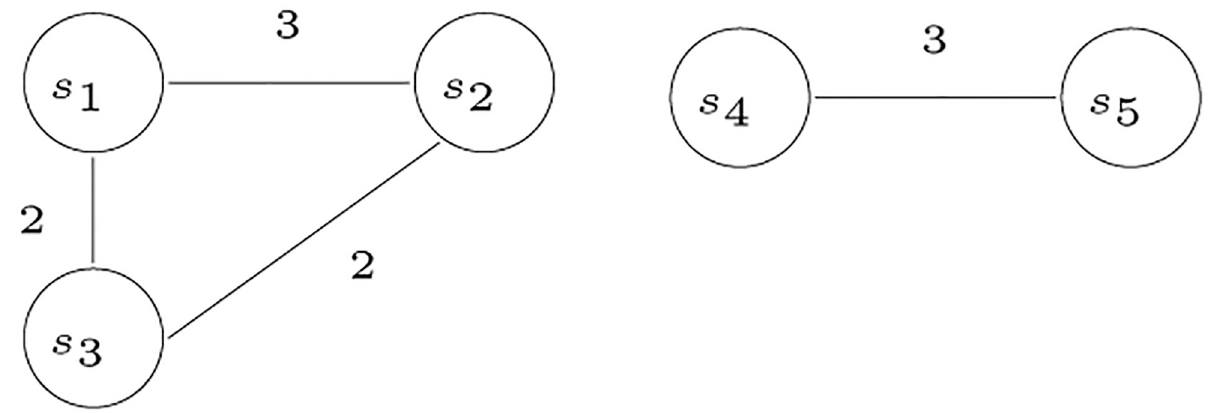
Fig 11. An undirected graph corresponding to the matrix shown in Table 2.